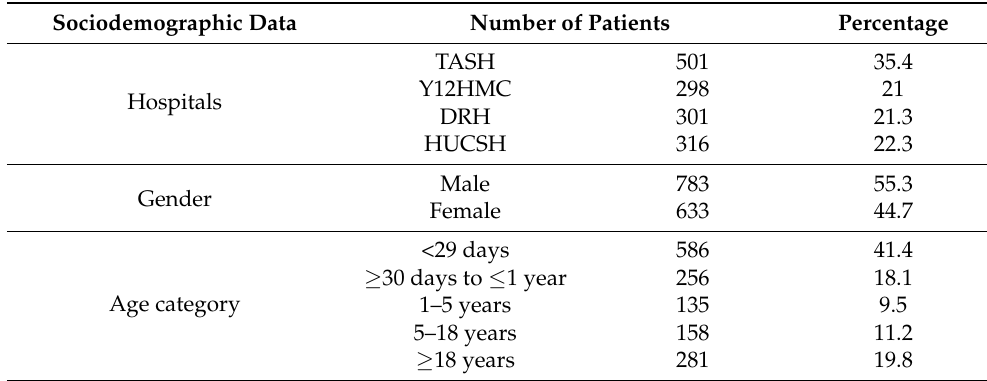
Table 1. Sociodemographic data of the patients investigated for sepsis at four different hospitals in